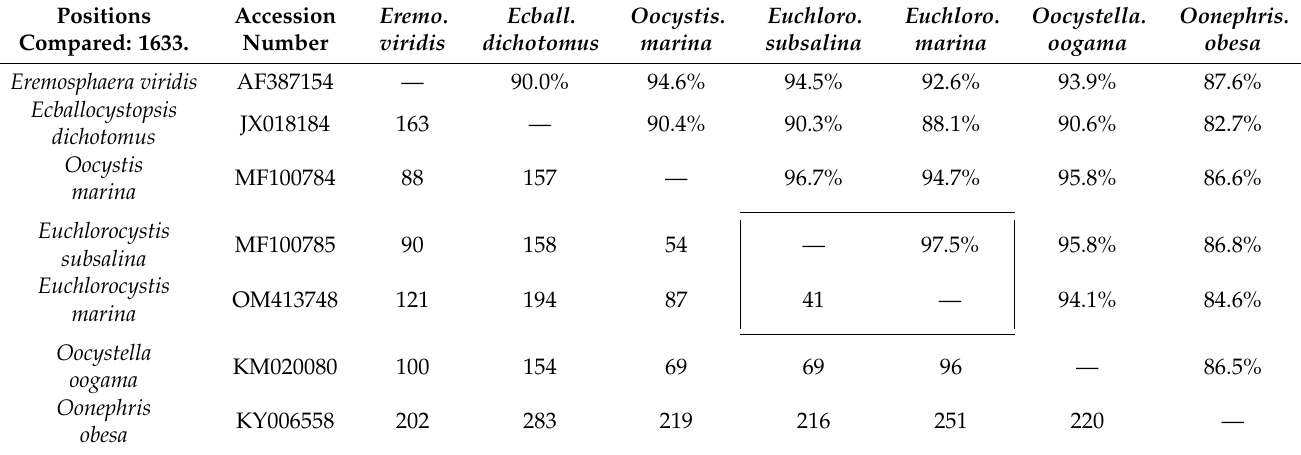
Figure 3. Maximum likelihood tree of 18S rDNA sequences. Bootstrap support from ML and NJ posterior probabilities are presented on the nodes. The sequence obtained in this study is shaded gray. The cell morphology picture of Euchlorocystis subsalina was from Liu et al. [17]. Table 1. Direct comparison of 18S rDNA sequences of Euchlorocystis marina (bold) with some species of the Oocystaceae family. Numbers below the diagonal indicate nucleotide substitutions between a pair of sequences and those above the diagonal are percent identities. Black boxed area indicates the high sequence similarities between the two closest related species.